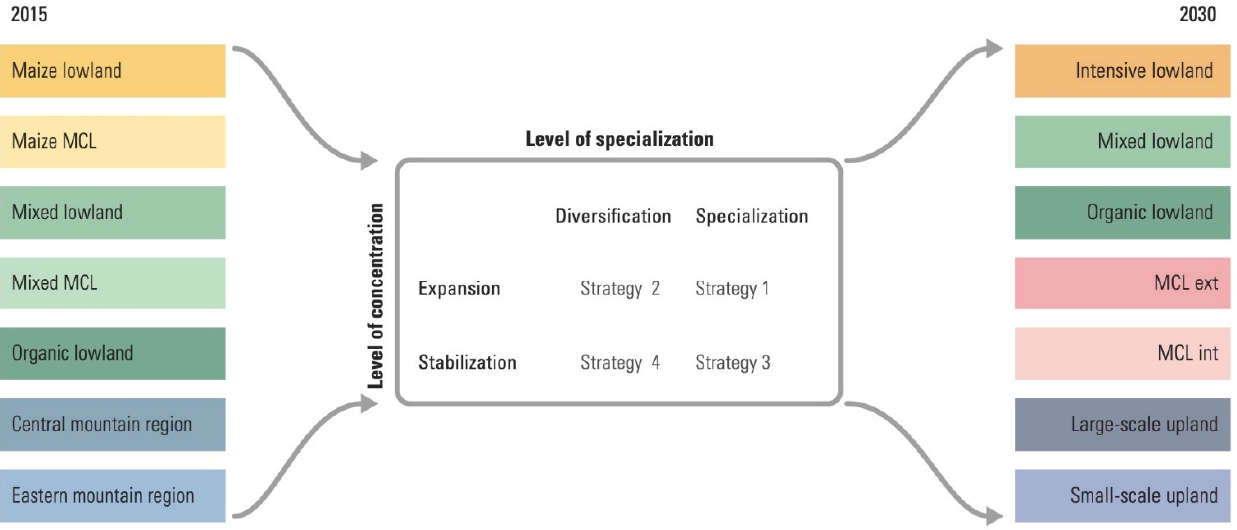
Figure 3. Analysing farming systems’ potential evolution to 2030. MCL: Mixed crop-livestock systems; Ext: extensive; Int: intensive.